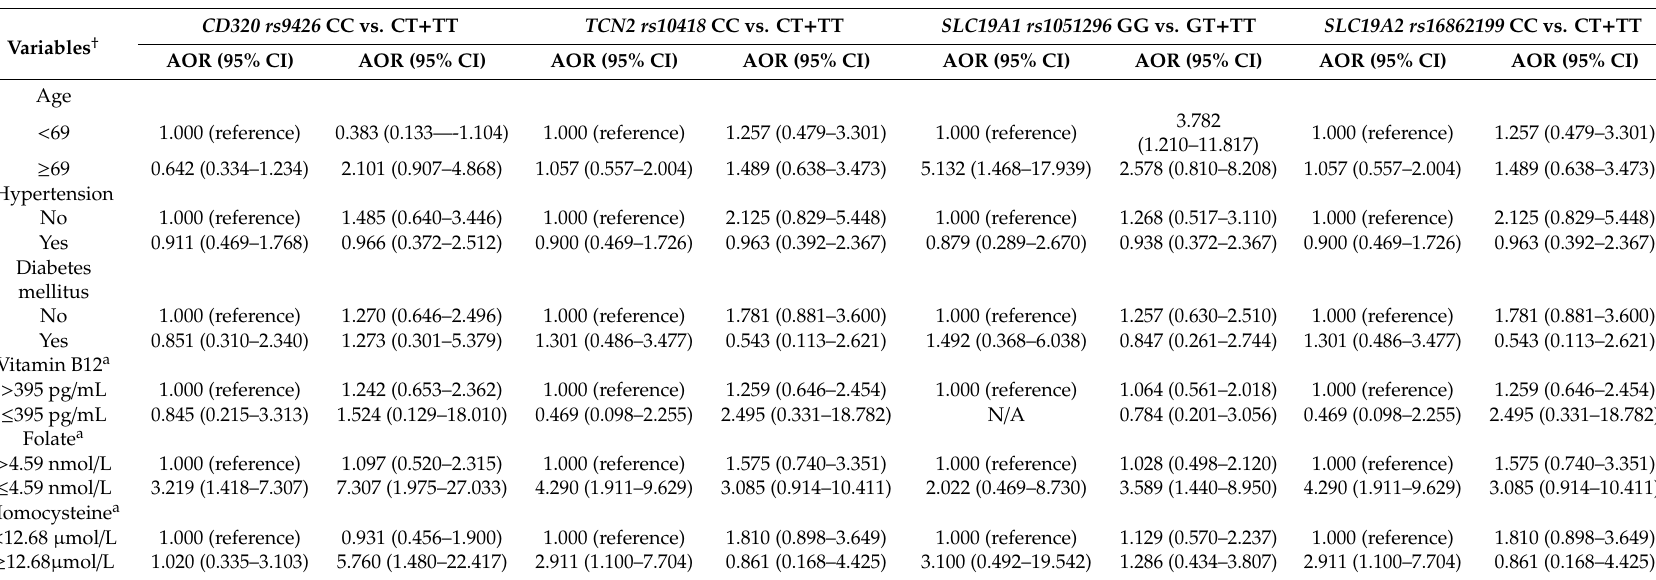
Table 5. Stratified analysis of OVCF incidence by interactions with age, hypertension, diabetes mellitus, and levels of vitamin B12, folate, and